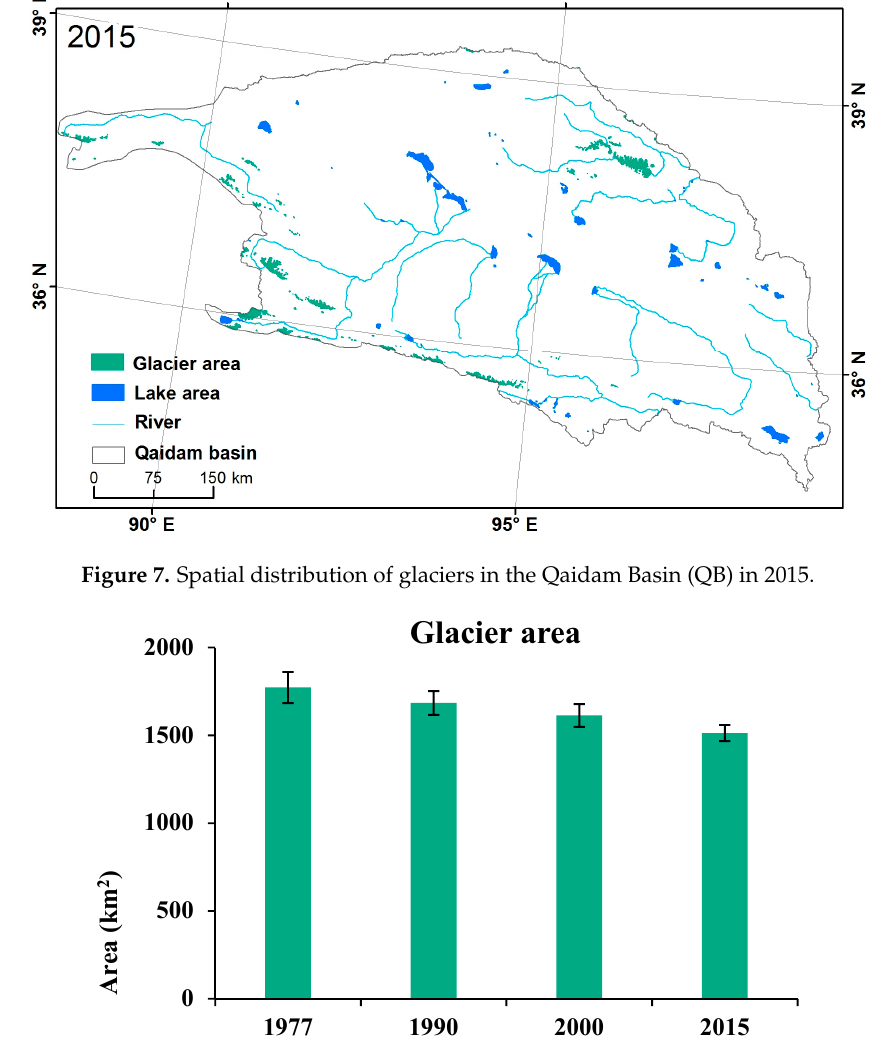
Figure 8. Changes of glacier area between 1977 and 2015. The error bars represent the confidence level of 95%.